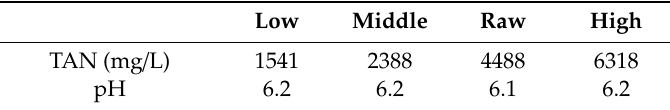
Table 3. The initial total ammonia nitrogen (TAN) concentration and pH value of blackwater in di ff erent experimental